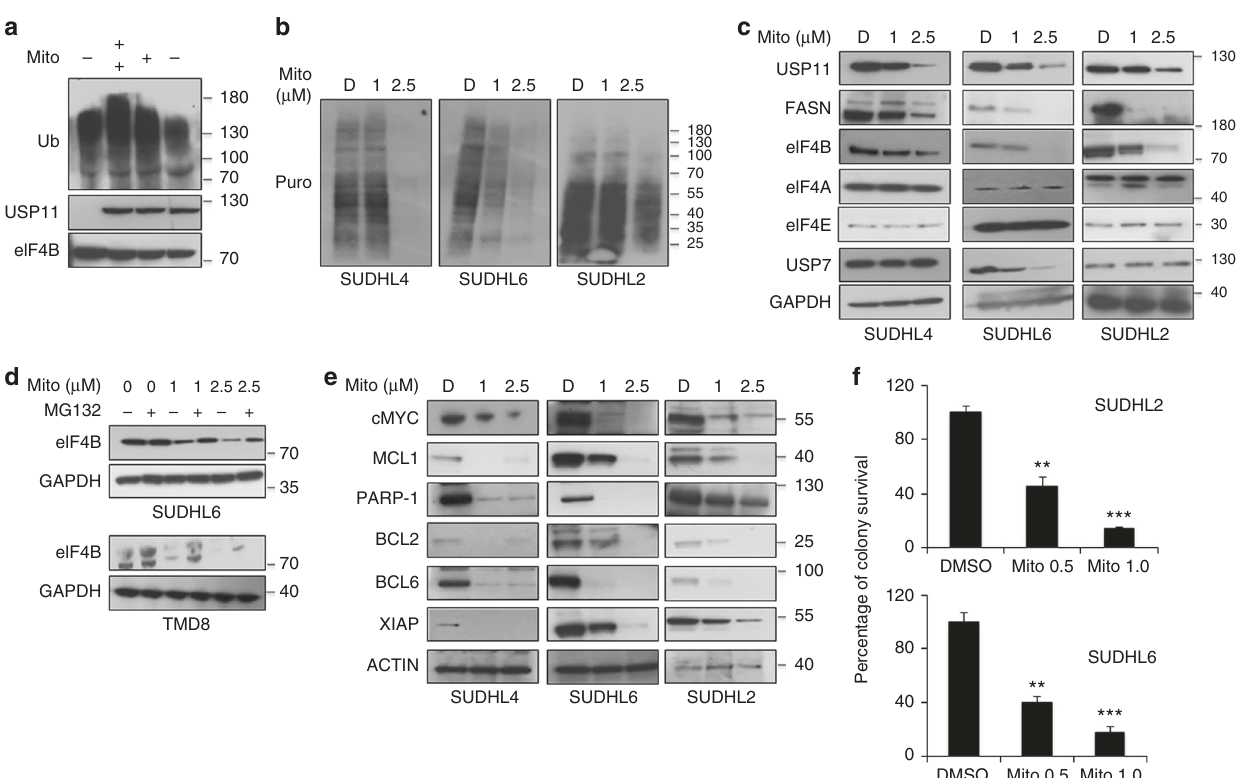
Fig. 7 Pharmacologically blocking USP11-mediated deubiqtuination in DLBCL. a In vitro deubiquitinase of eIF4B assay. Incubation of polyubiquitinated eIF4B with enriched USP1-HA in presence of increasing concentration of Mitoxantrone (Mito). Lysates were resolved and probed for indicated antibodies. b , c Indicated cells were cultured with Mito (indicated concentration) for 14 h. Post treatment, cells were incubated with puromycin (1 μ g/mL) and lysates were probed with anti-puromycin for SUnSET assay ( b ). Same lysates were also probed for indicated antibodies ( c ). GAPDH was used as internal loading control. d SUDHL6 and TMD8 were treated with Mito (indicated concentration) for 14 h followed by treatment with MG132 (10 μ M) for 2 h. Lysates were probed for the indicated antibodies. GAPDH was used as loading control. e Lysates (From 7B) were resolved and probed for indicated antibodies. Actin was used as loading control. f Percentage colony survival of SUDHL6 and SUDHL2 treated with Mito (indicated concentration), normalized to vehicle control DMSO (0.1%), ** p < 0.01, ** *p <